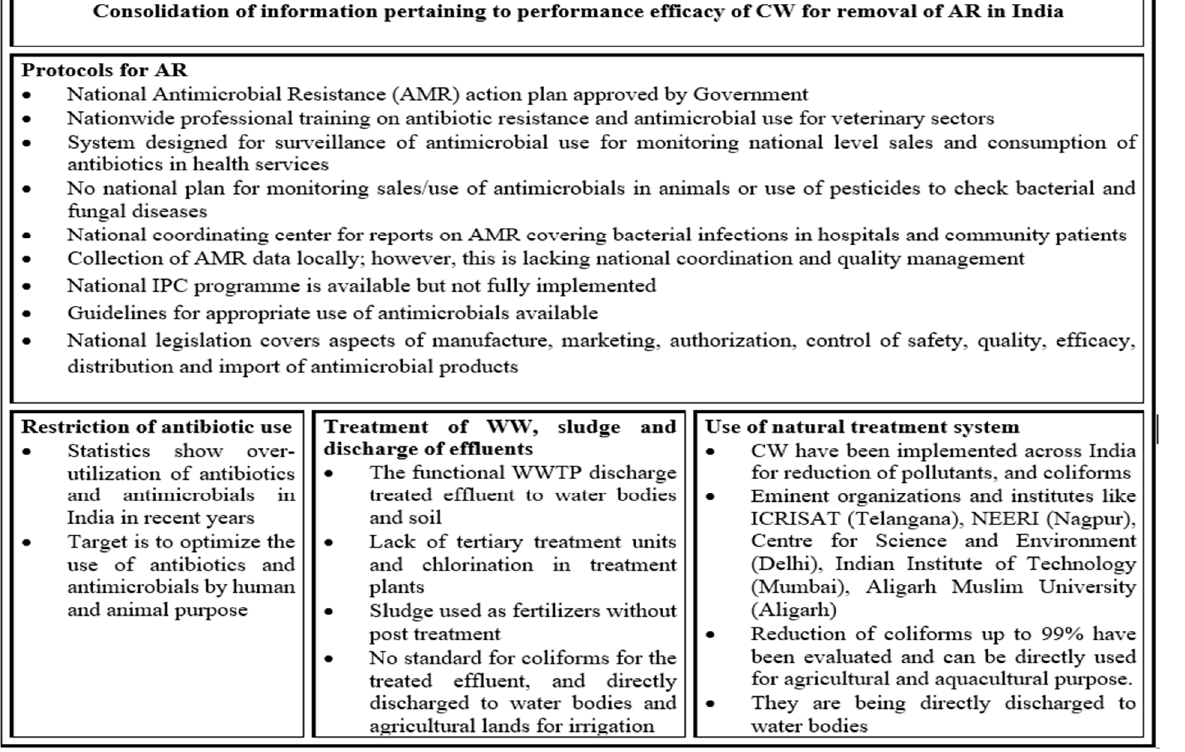
Figure 3. Flow diagram representing, in brief, the protocols for antimicrobial resistance and benefits of using CWs in various organizations/institutes in India.